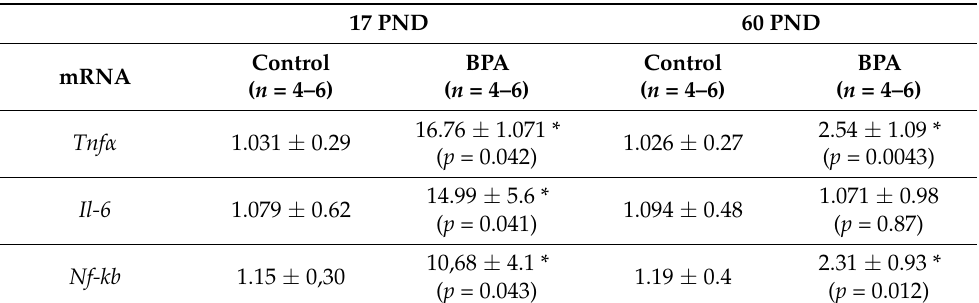
Table 3. Expression analysis of inflammation biomarkers in lactating (17 PND) and weaned (60 PND) animals.